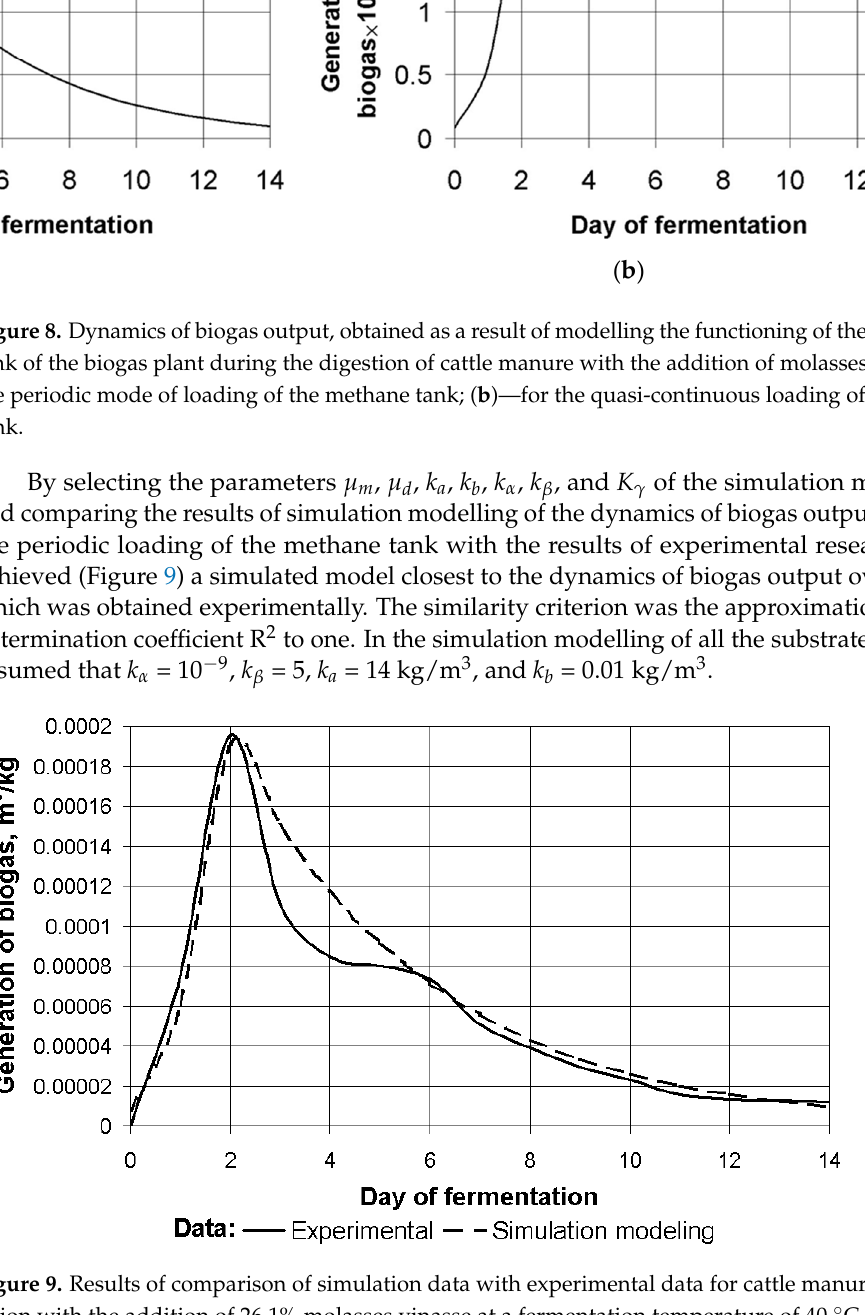
Table 2. The coefficients of the simulation model of biogas output during cattle manure digestion with the addition of a molasses broth at a fermentation temperature of 40 °C.